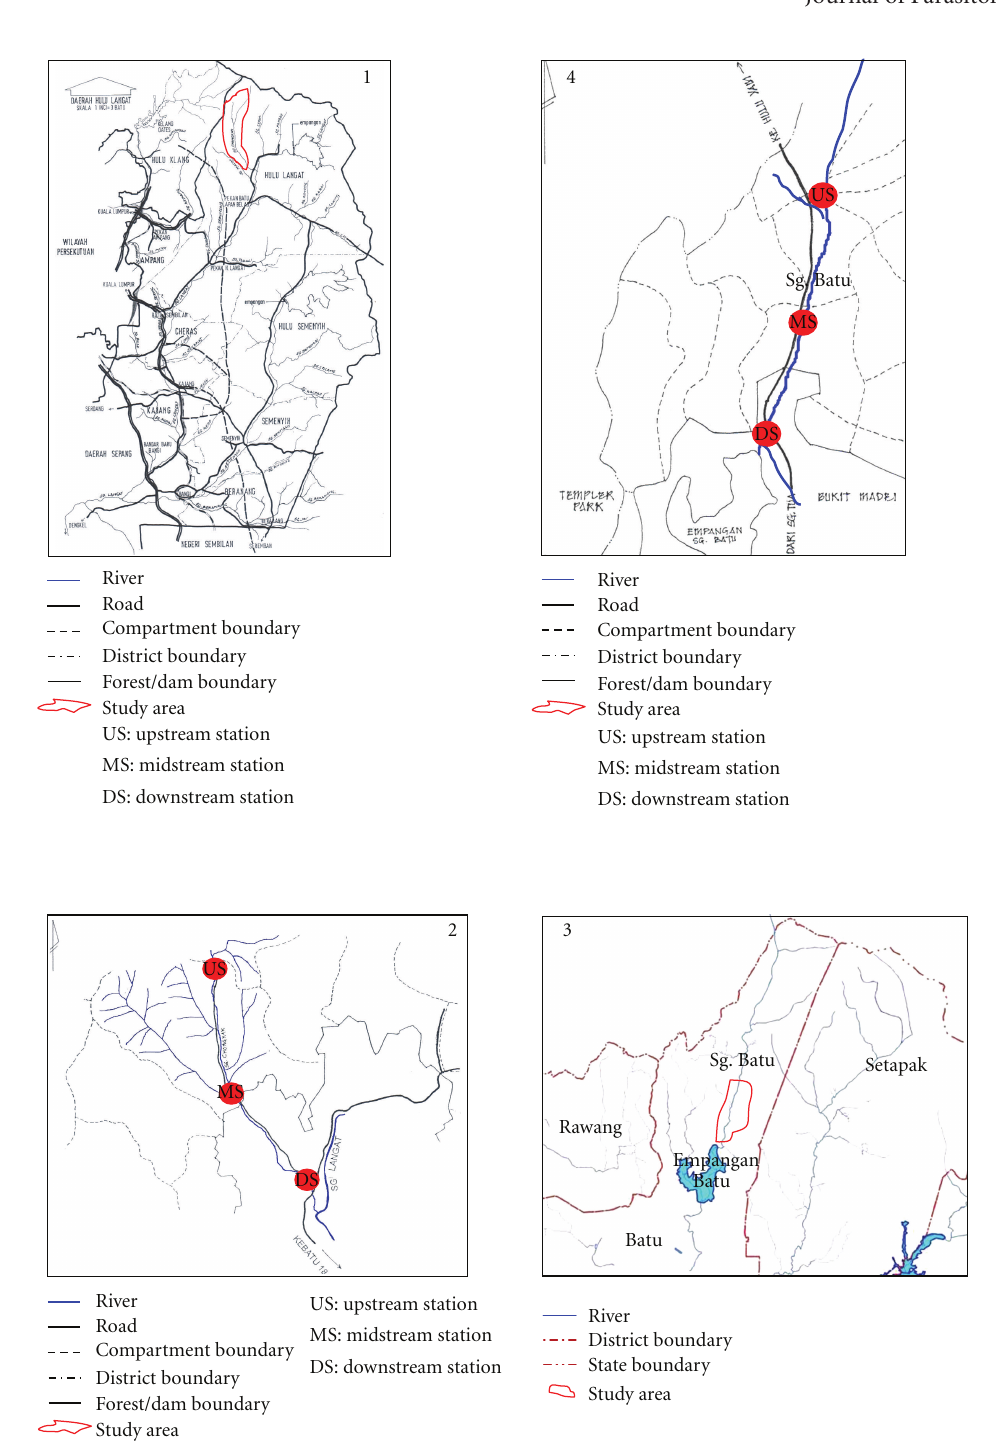
Figure 1: Map showing the locations of sampling stations at study area of Sungai Congkak (1 and 2) and Sungai Batu (3 and 4), Selangor,